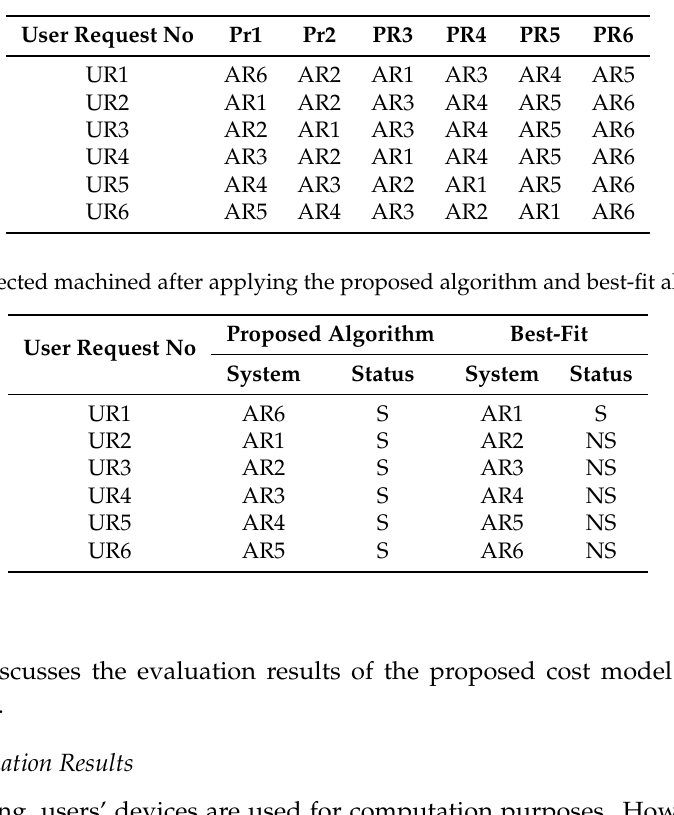
Table 3. Resource priority of the users.